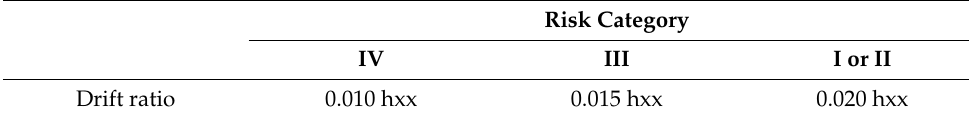
Table 2. Allowable inter-story drift ratio for IBC